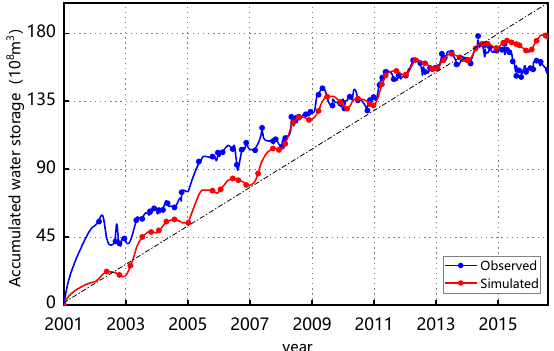
Figure 3. Changes of lake water storage in Siling Co (Based on May 2001).